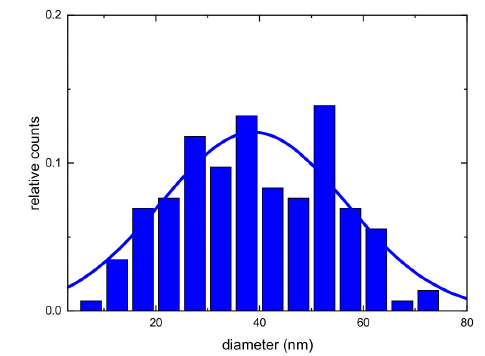
Figure 3. Distribution of the diameters D of the Au nanoparticles in the samples deposited by chemical reduction. The continuous line is the Gaussian fits of the experimental data.